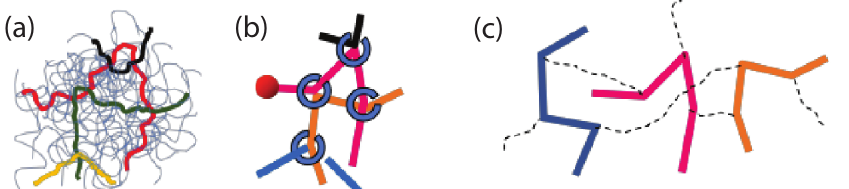
Figure 12. Schematics of slip-spring models. ( a ) Entangled chains colored in an entangled polymer melt, ( b ) corresponding slip-spring primitive chain network (PCN) model [178], and ( c ) a group of chains considered in the Doi and Takimoto (DT) model [179]. Reproduced from [183] with permission from